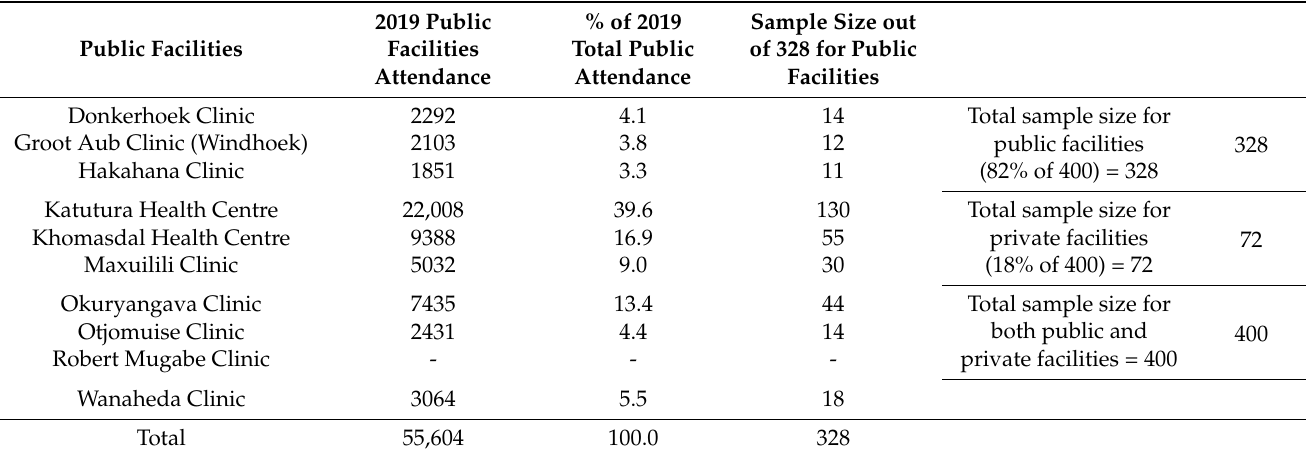
Table 1. Summary of sample size